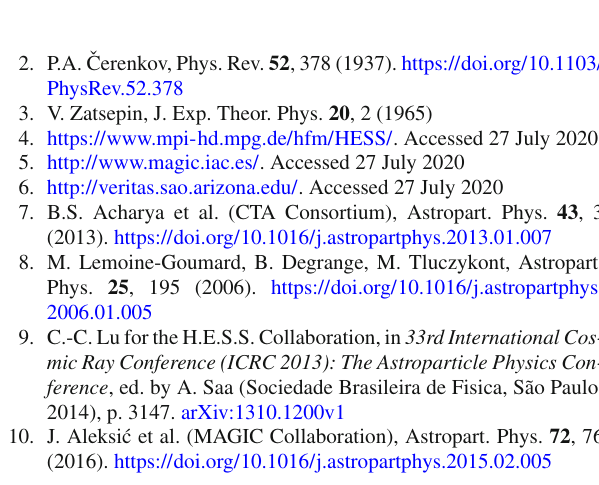
Fig. 8 Relative deviation between models of Sect. 2 (blue dashed) and Sect. 3 (orange solid) and the simulated angular distribution of Cherenkov photons in the region of small angles. Curves are shown for three shower ages, indicated in the